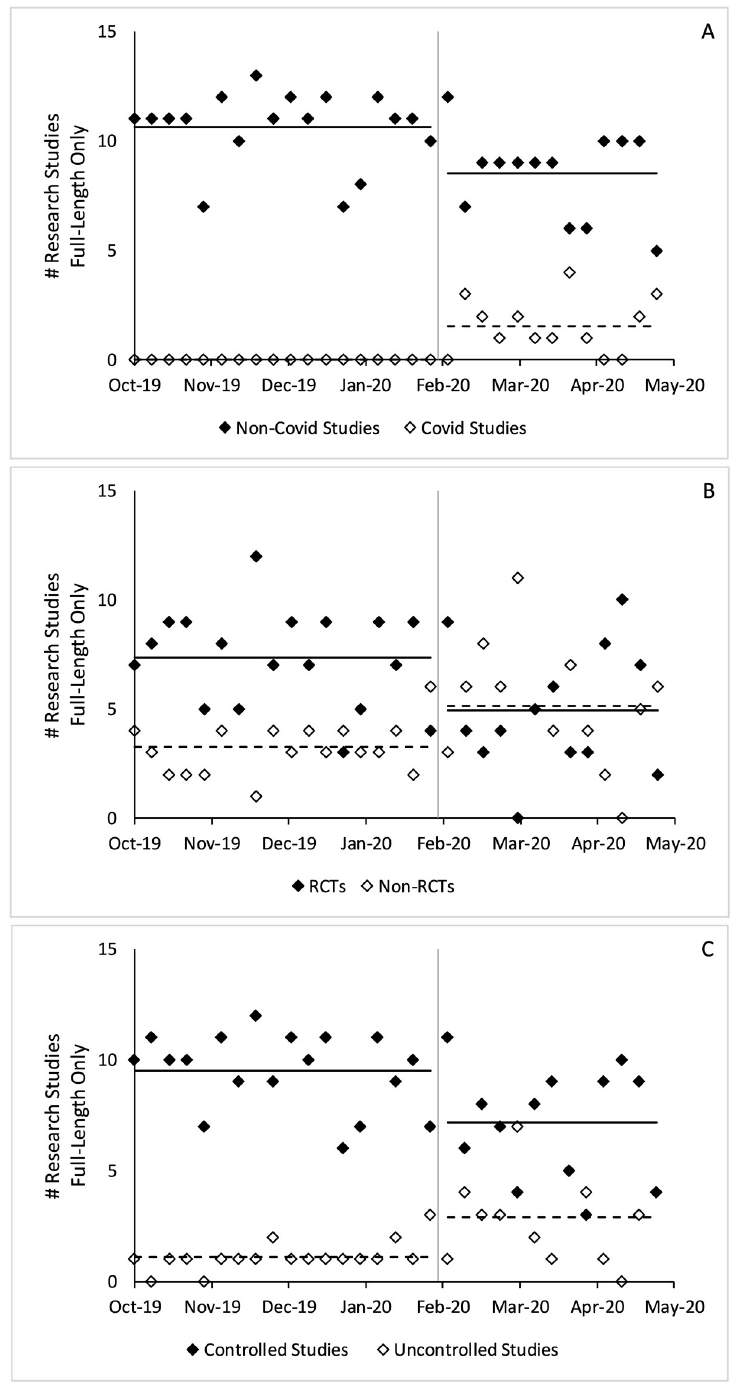
Fig 2. Changes in full-length research studies published before and after Covid-19. Figure includes all full-length research studies in counts per week. A) Covid-19 versus non-Covid-19 studies, B) controlled versus uncontrolled studies, C) RCTs versus non-RCTs. P-values estimated using a two-sample t-test. The gray vertical lines denote January 31, 2020, the boundary between the pre- and post-Covid-19 eras. Solid horizontal lines denote average values of the solid dots and dashed horizontal lines denote average values of the hollow